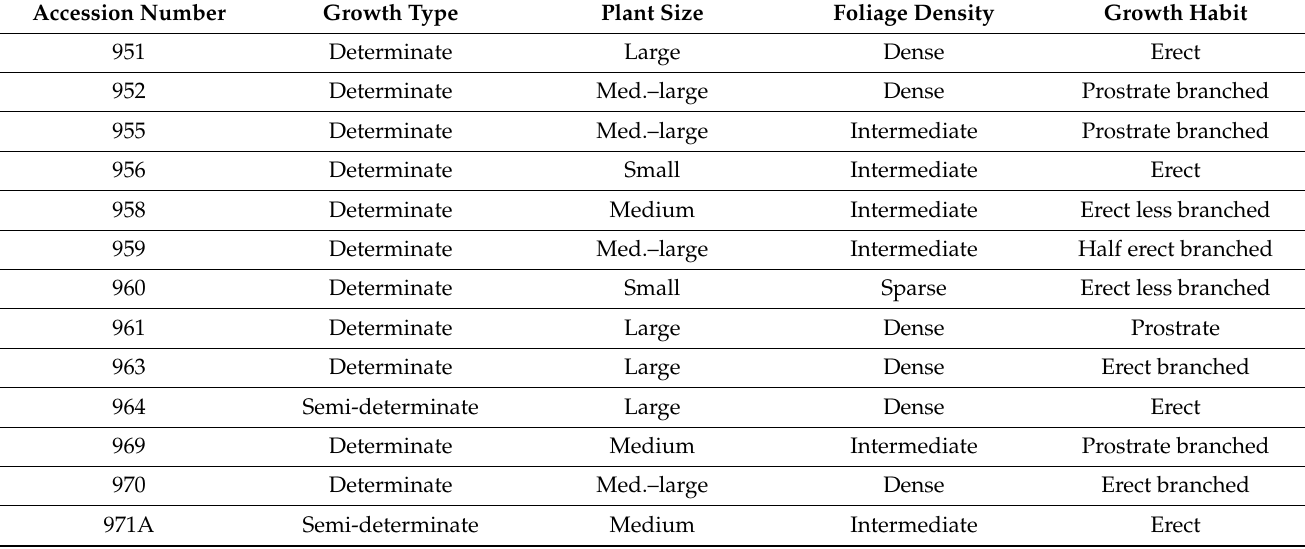
Table 1. Vegetative characters of the 29 Jordanian tomato